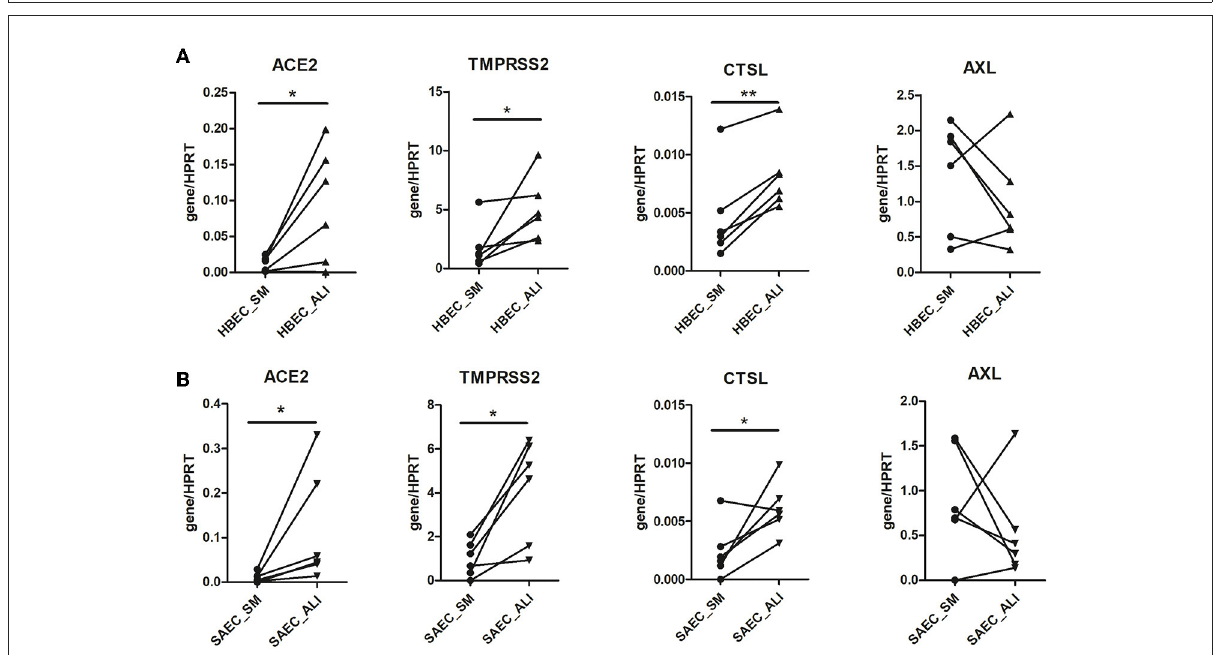
FIGURE2 Effect of cell culture systems on the expression of SARS-CoV-2 entry genes in primary human airway epithelial cells. Human bronchial epithelial cells (HBEC) (A) and small airway epithelial cells (SAEC) (B) derived from the same donors were submerged cultured (SM) or differentiated under air-liquid interface (ALI) conditions (4 patients, 6 cultures). Gene expression of SARS-CoV-2 entry genes including ACE2, TMPRSS2, CTSL and AXL was determined by LightCycler PCR and normalized to HRPT expression. Expression of the four SARS-CoV-2 genes in HBEC and SAEC cultured in submerged culture was compared with those in ALI culture. Statistical significance was determined by paired t test ( n = 6). * p < 0.05 and ** p <